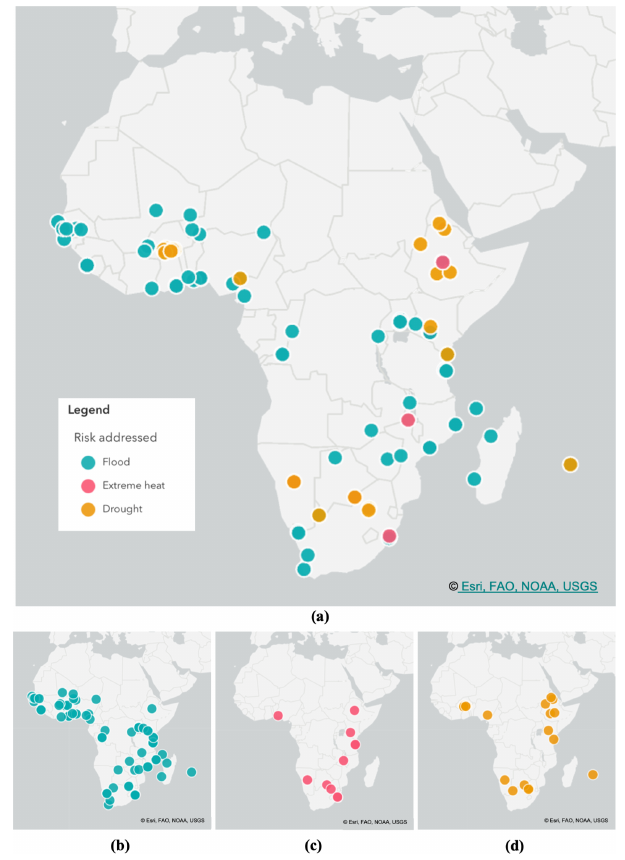
Figure 5. Map of the locations of all the reported NBSs in SSA to mitigate hydro-meteorological risks. (a) Locations of all risks studied; (b) locations of papers studying floods only; (c) locations of papers studying extreme heat only; (d) locations of papers studying drought only.